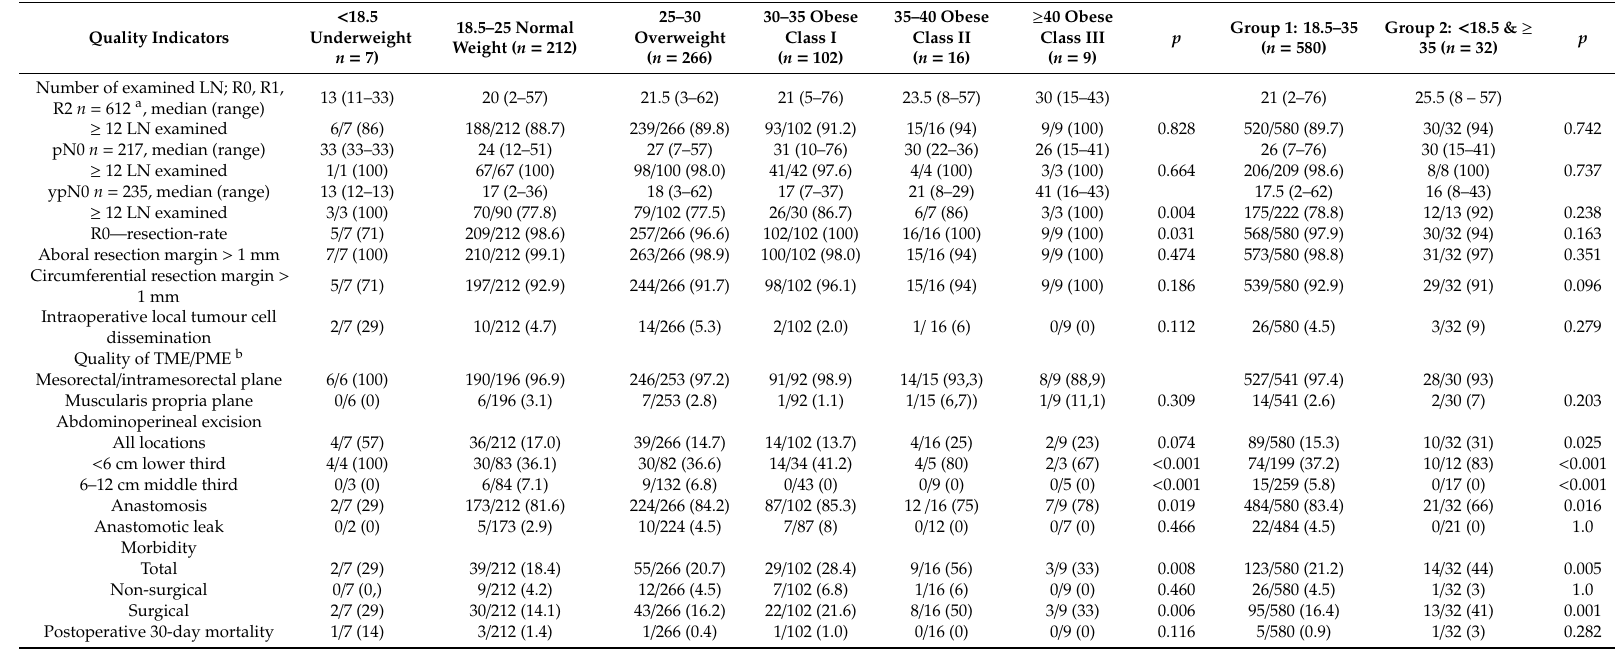
Table 3. Surgical quality indicators for 612